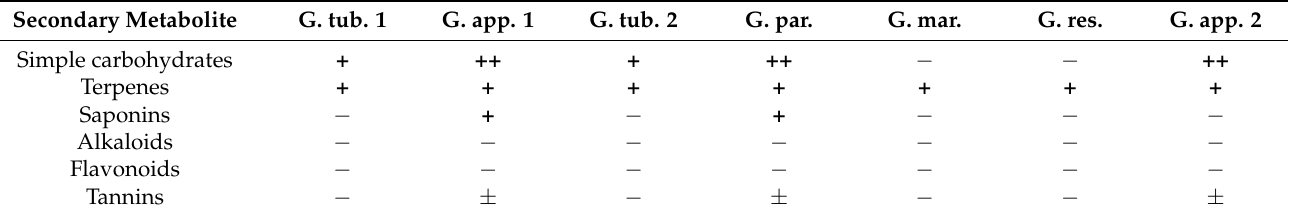
Figure 6. Intracytoplasmic β -catenin immunostained cells after a 24 h treatment with CisPt 20 µ M and/or the G. tub. extract (10 µ g/mL), the G. par. extract (10 µ g/mL) or the G. tub., and G. par. association extract (each at 5 µ g/mL). Cells were analyzed by flux cytometry and results are shown as mean of normalized fluorescence compared to controls ± SD of three independent experiments (**** p < 0.0001 compared to controls; #### p < 0.0001 and ### p < 0.001 compared to CisPt. 20 µ M). The signs + and − indicate the presence or the absence of the corresponding treatment, respectively. Table 1. Phytochemical screening results of methanolic extracts of the 7 studied specimens. The signs +, ± and − indicate the presence, the suspected presence or the absence of the corresponding secondary metabolite, respectively.